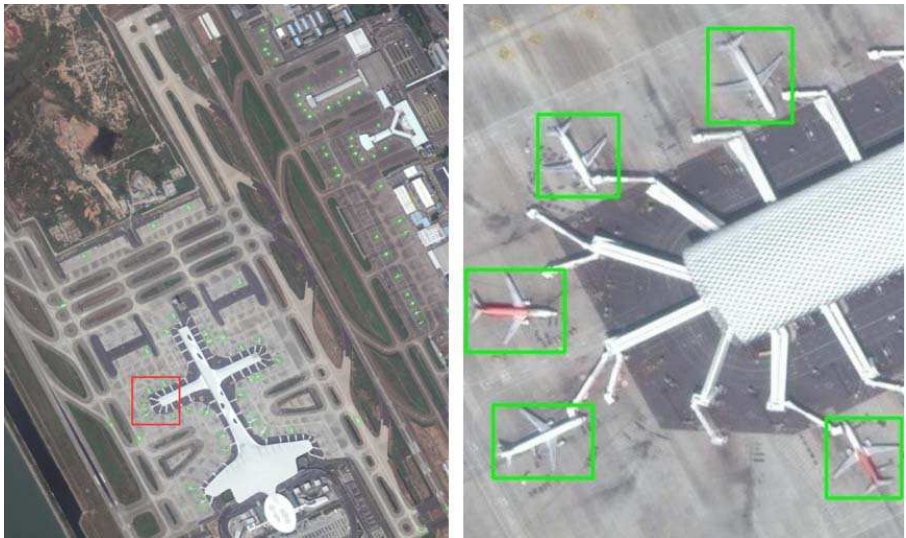
Figure 4. The high-resolution remote sensing image of Baoan Airport. Table 1. The experimental dataset.